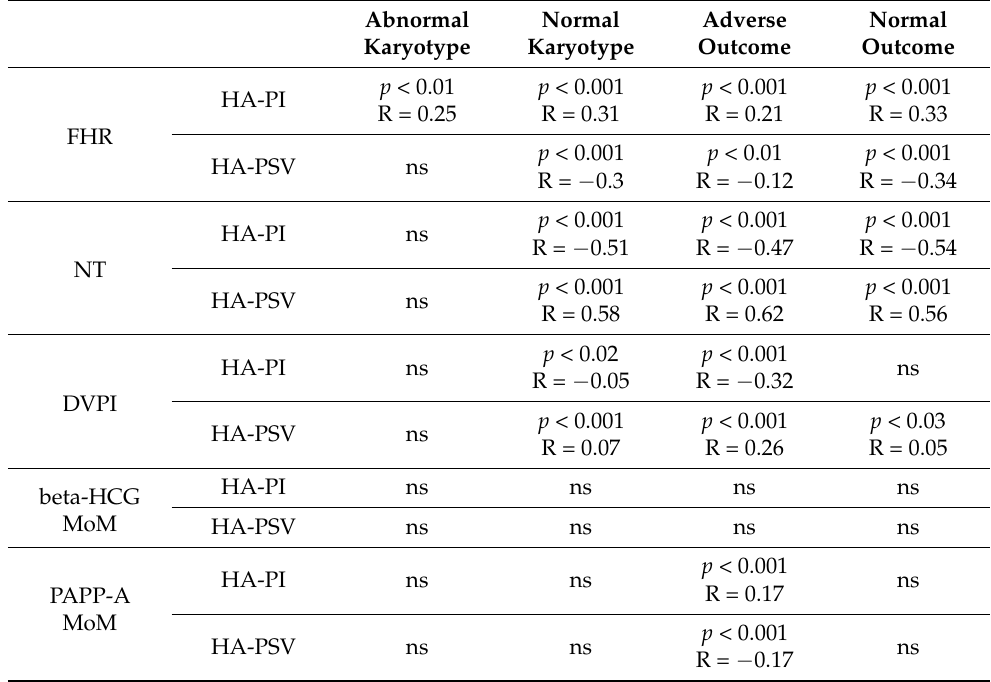
Table 8. Correlations between hepatic artery flows and selected first-trimester screening parameters depending on the karyotype and the adverse pregnancy outcome (ns = not